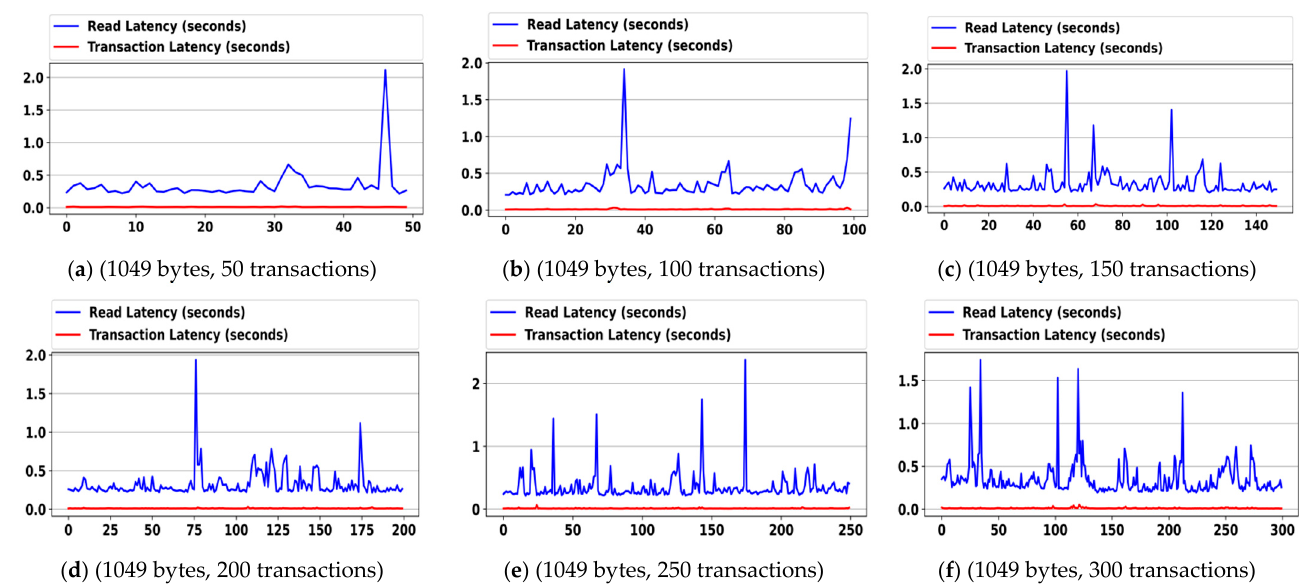
Figure 4. Impact of the transactional data size, 1049 bytes on RL, and TL for ( a ) 50, ( b ) 100, ( c ) 150, ( d ) 200, ( e ) 250, and ( f ) 300 transactions.